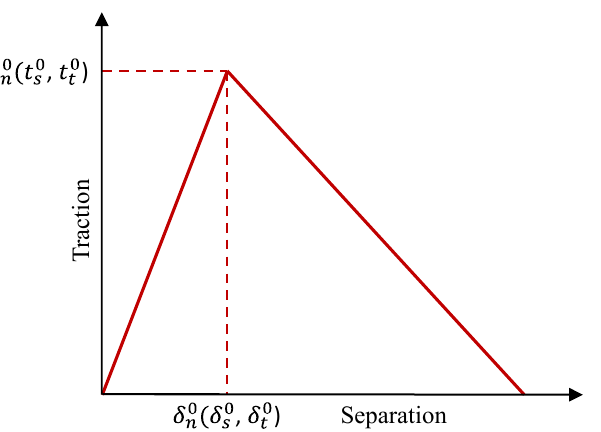
Figure 10. Traction versus separation model adopted in the performed FE analysis.